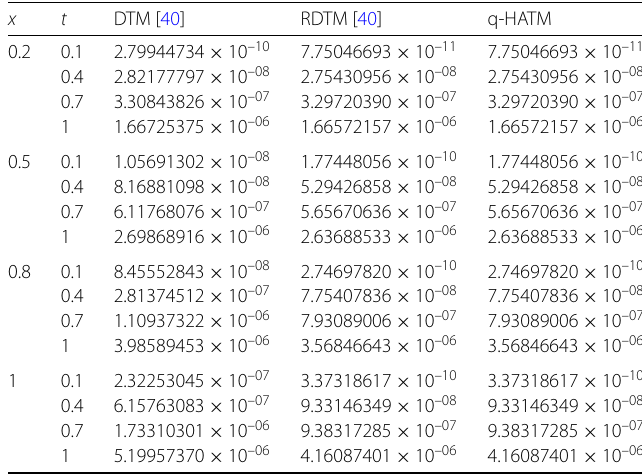
Table 8 The comparison of T (3) solution obtained by DTM, RDTM [40], and q-HATM with the exact solution Equation (32) in terms of absolute error when α = 1, (cid:2) = –1, k = η = 0.1, p = 1.5, r = –1.5, and n = 1 for Example 4.1